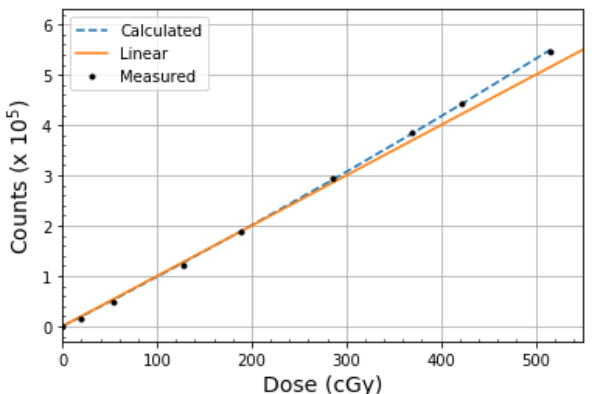
Figure 10. Dose linearity results. The relationship between OSLD response and absorbed dose. For each data point, a single OSLD was irradiated, kept in the dark for a minimum of 10 min, and then readout. The solid orange line represents OSLD linear response to dose. Meanwhile, the blue dashed curve models the data obtained from this experiment and is described by Equation (1).